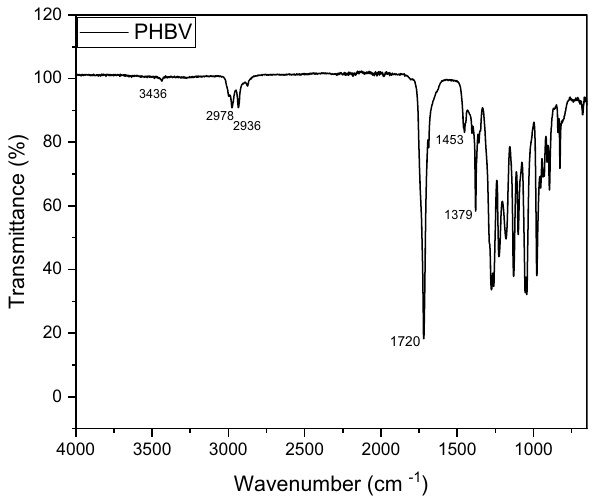
Figure 1. FTIR spectra of neat PHBV.